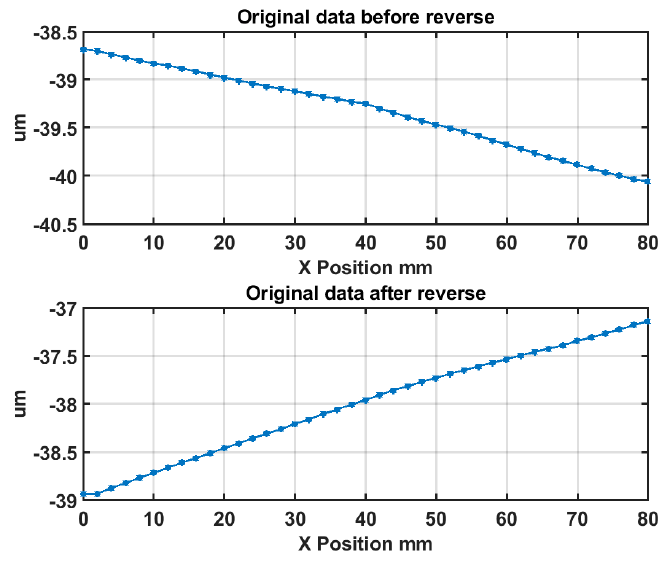
Micromachines 2018 , 9 , x Figure 13. Experimental setup of E BOC measurement. Figure 13. Experimental setup of E BOC measurement.